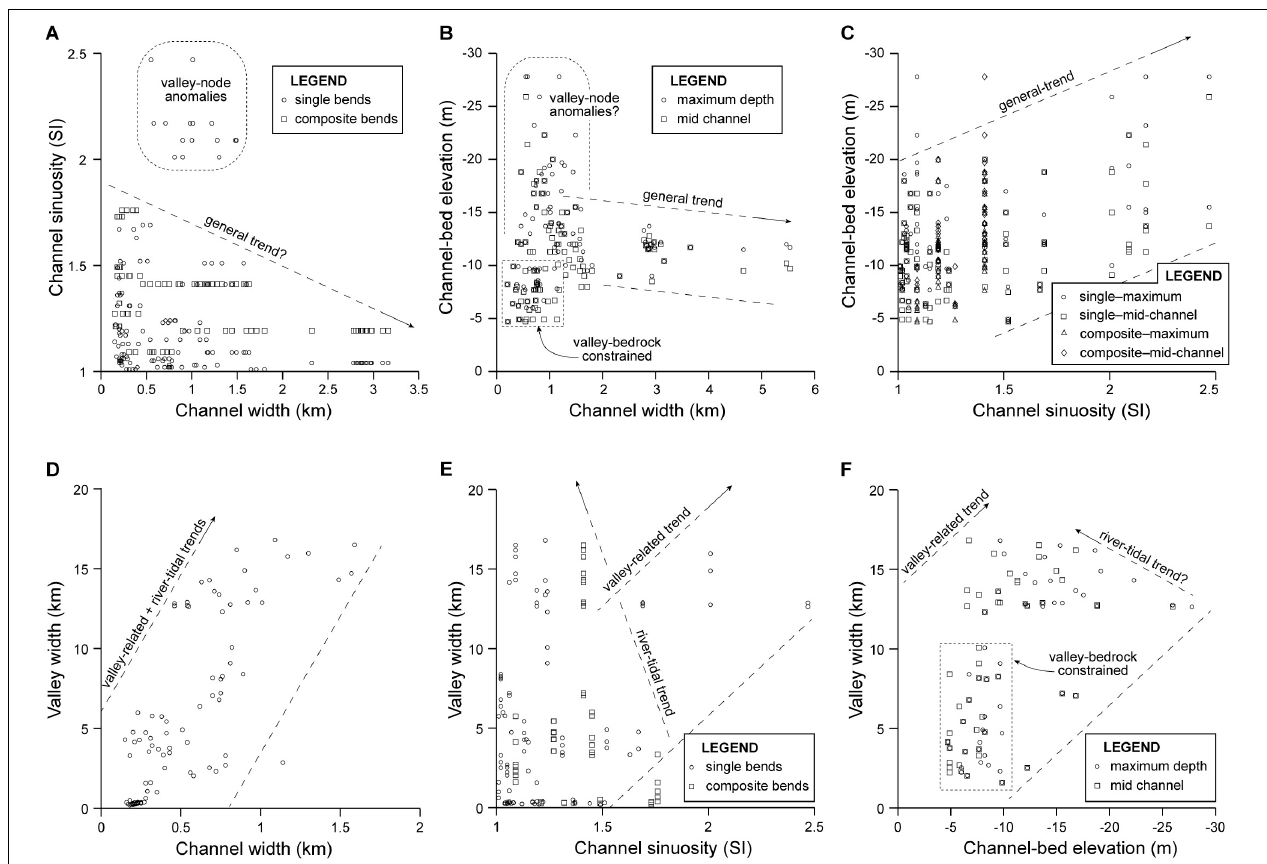
of the channel, and additional changes in channel width and bed elevation. These areas are considered here as important nodes in this system ( Figure 8 ). The upstream node is located at approximately 120 km from the river mouth and it